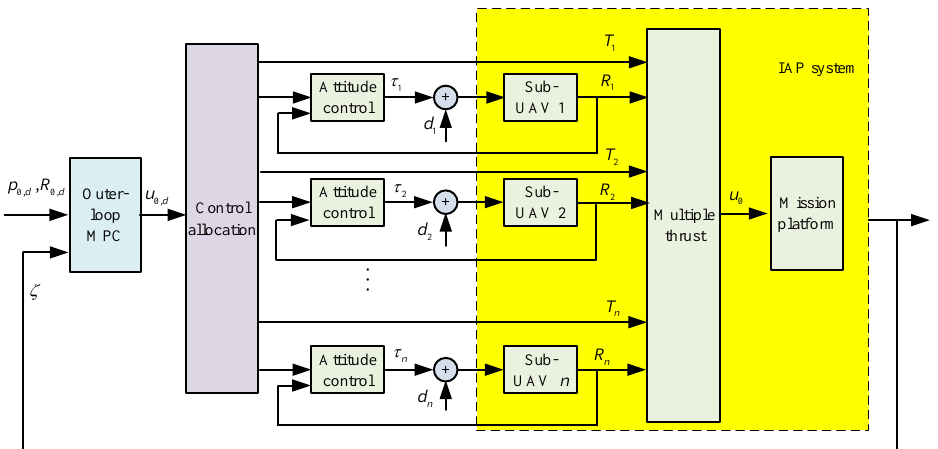
Figure 2. Architecture of the overall IAP controller based on geometric model predictive